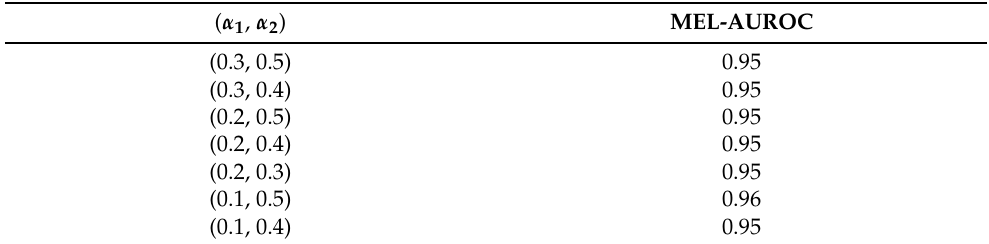
Table 3. Result of the best combination of hyper-parameters α 1 and α 2 obtained with grid-search on the validation